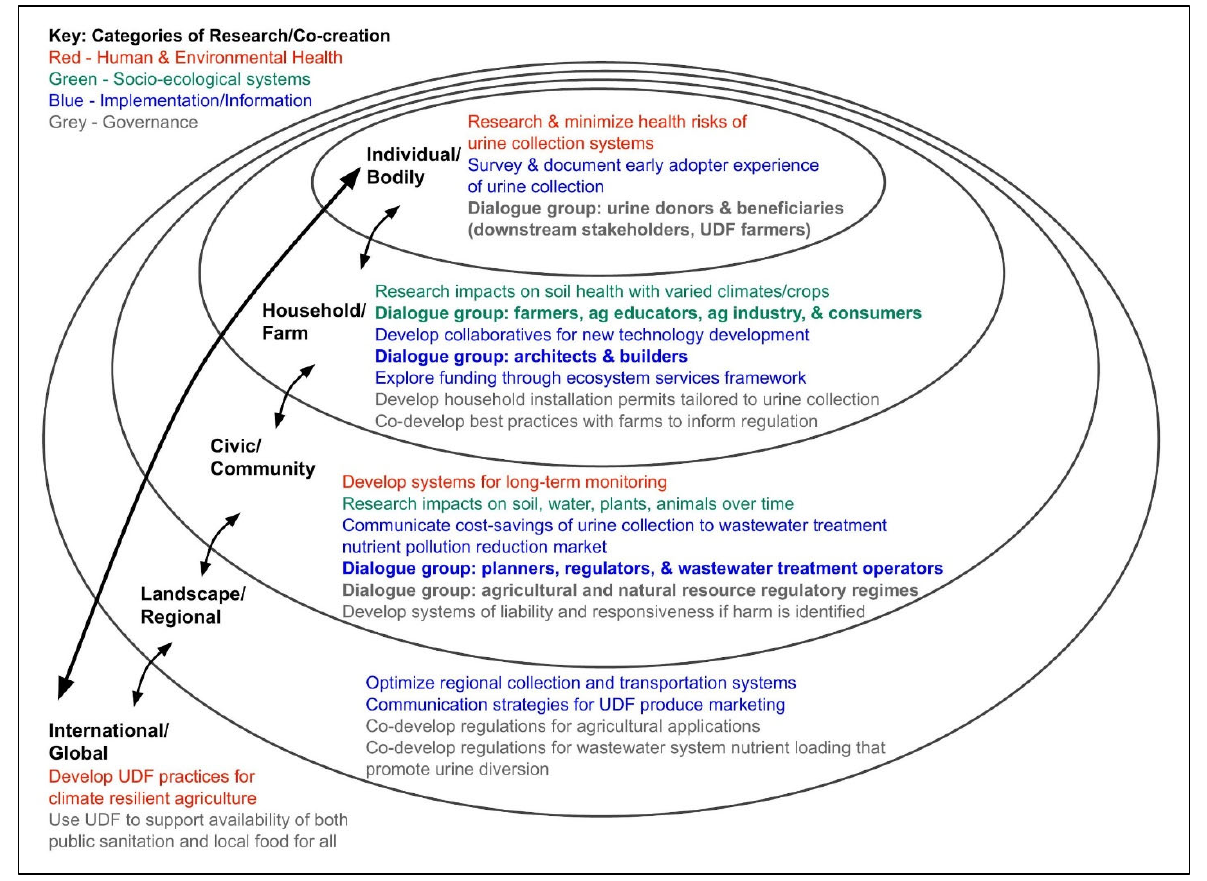
Figure 2. Priorities for Research and Co-creation Figure 2 parallels our initial representation of the nested risks revealed by our research, to show priorities for action re- search going forward, reflective of those concerns. The color coding here represents categories for co-creation of research and implementation strategies and tools across permeable scales. Red suggests research in the realm of human and envi- ronmental health; green concerns wider socio-ecological systems; blue concerns methods of communication and imple- mentation; and grey addresses governance, policy, and